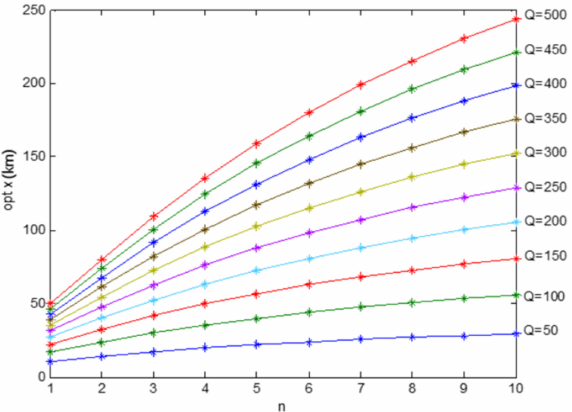
Figure 6. The optimal x under different n